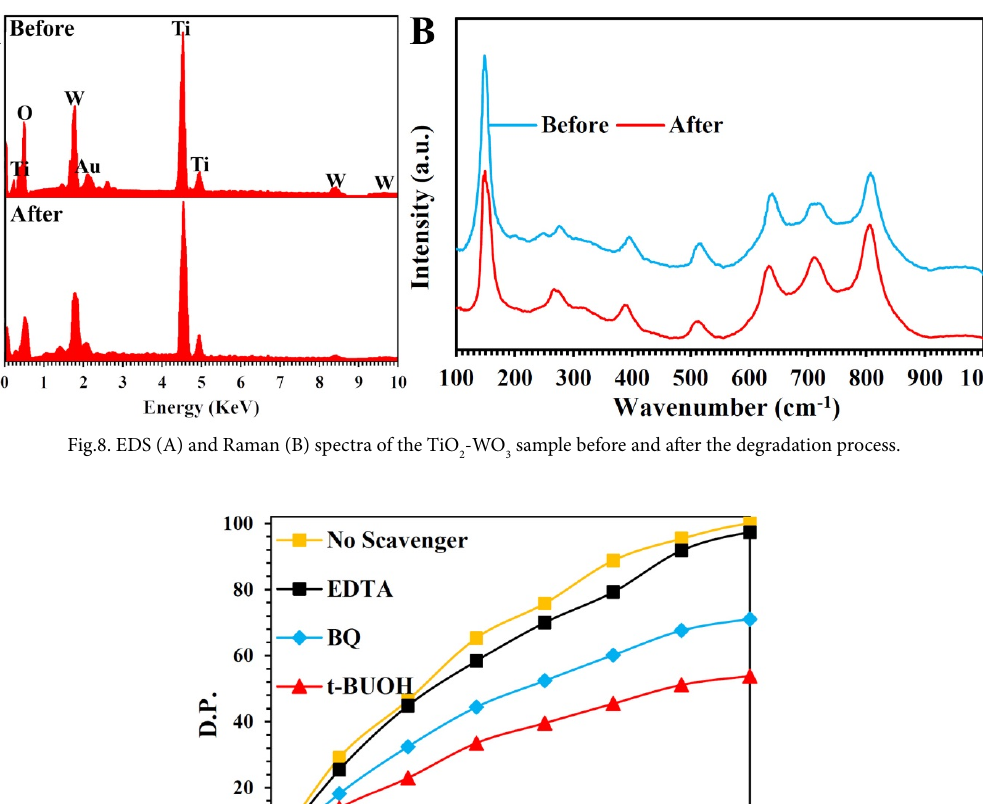
Fig. 9. Photocatalytic performance of TiO